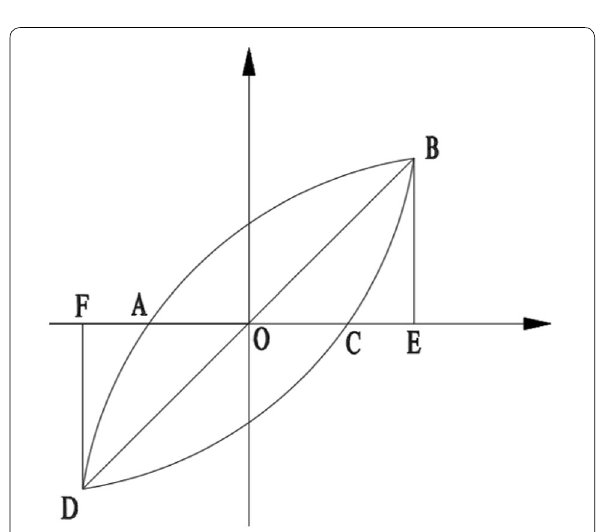
Fig. 11 Typical hysteretic loop.